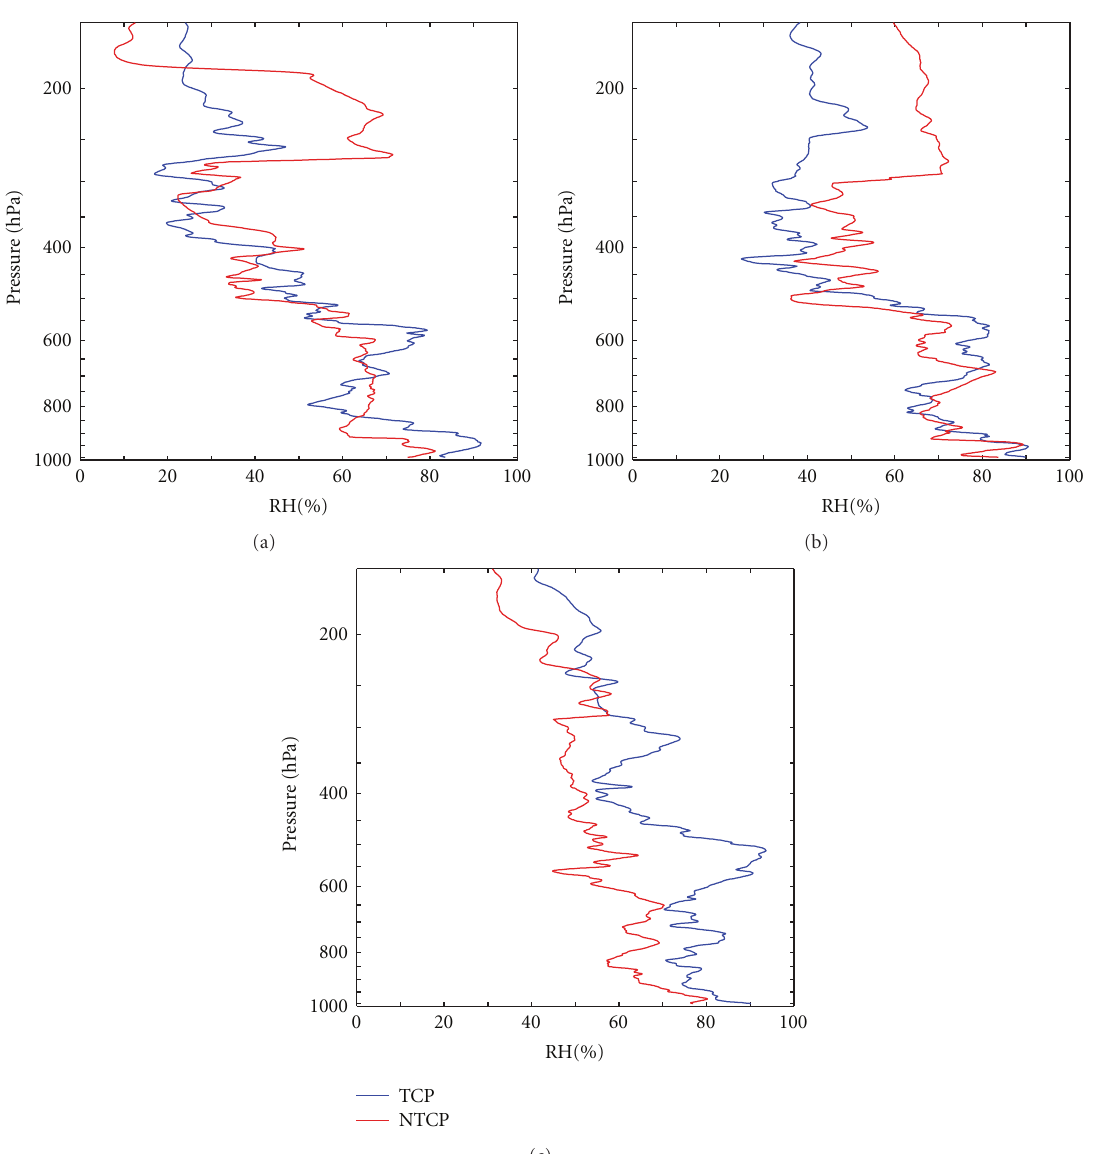
Figure 6: Relative humidity with height for (a) prior to, (b) during, and (c) after MCS propagation through the domain. The blue line is for the mean TCP case and the red line is for the mean NTCP